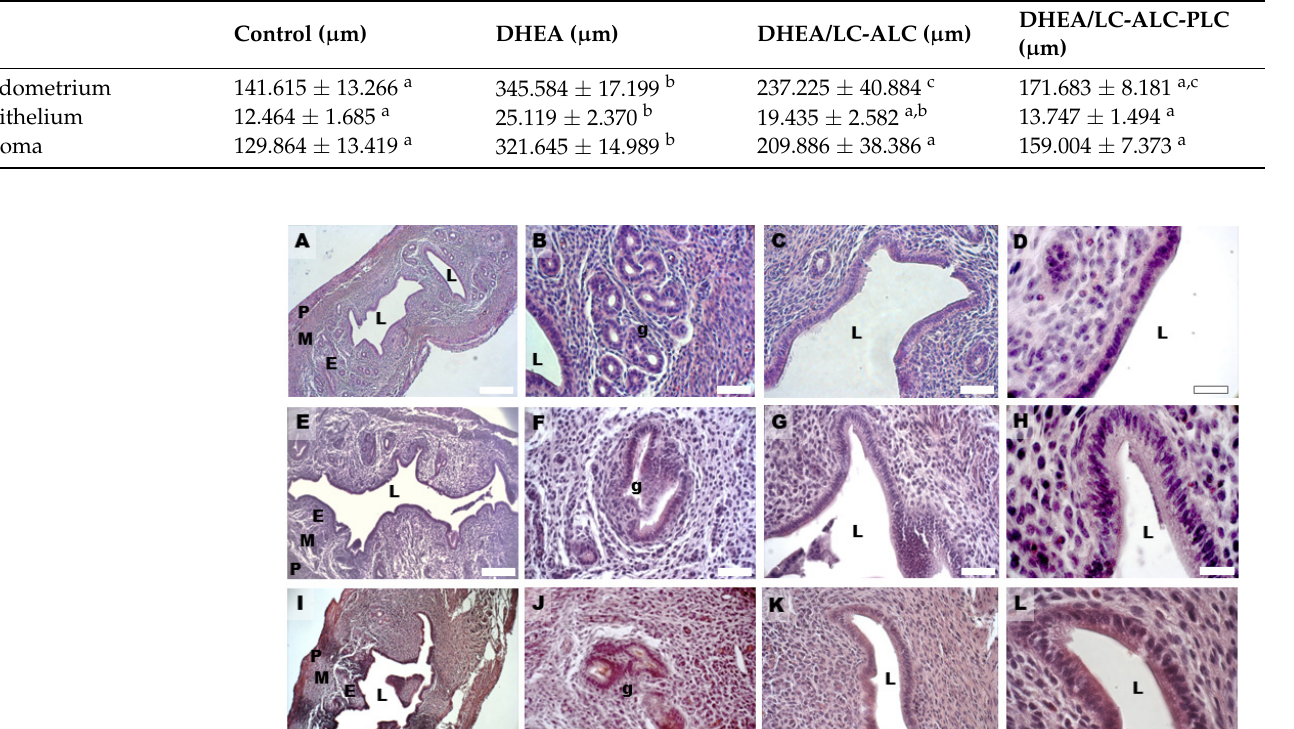
Table 1. Morphometric measurements on the thickness of the endometrium, epithelium and stroma of mouse uteri. Values are expressed as mean ± SD, Differences evaluated by ANOVA followed by Tukey’s test. Superscripts indicate a significant difference ( p < 0.05).